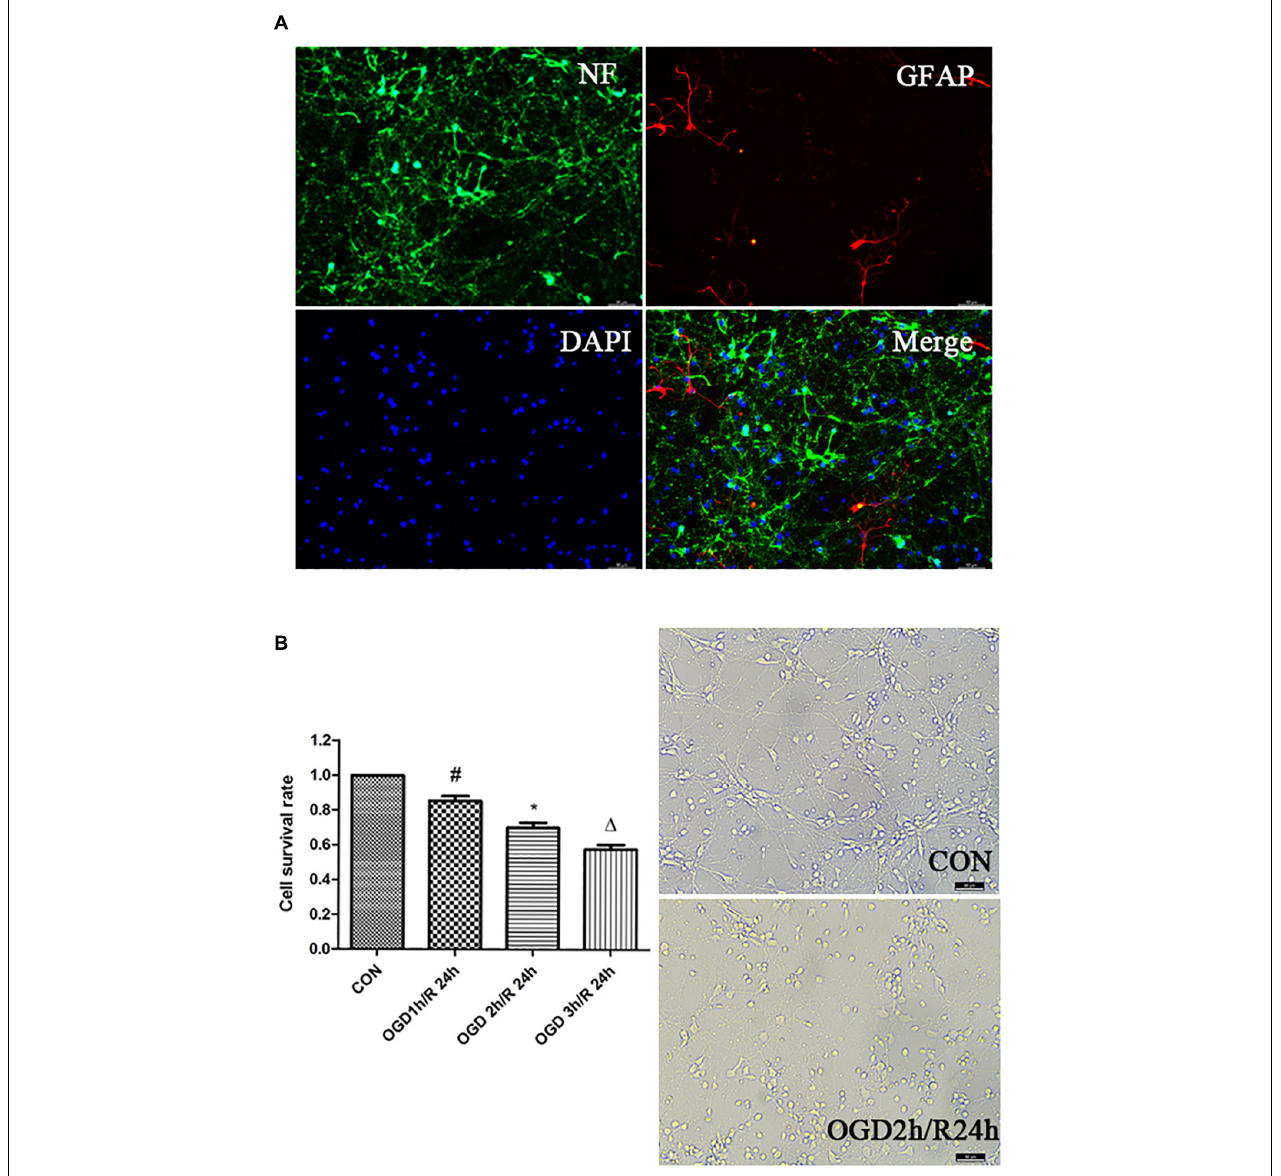
FIGURE 1 | Establishment of OGD/R model. (A) Identification of primary cortical neurons. Double-labeling immunofluorescence staining with the neuron marker NF (green) and the astrocyte marker GFAP (red); nuclei stained with DAPI; scale bar: 50 µ m. (B) Effects of different time of OGD/R on neuron viability. Cell viability was measured by CCK-8 assay. # P < 0.01 vs. control; * P < 0.01 vs. control; (cid:49) P < 0.01 vs. control.